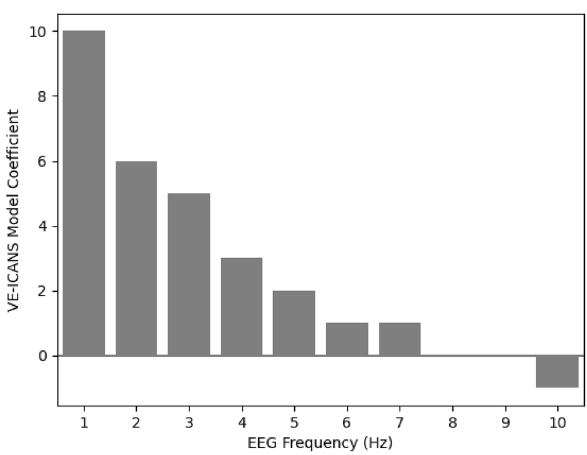
Figure 4. VE ICANS coefficients for each frequency (Hz) of slowing. A bar plot of the assigned coefficient values (y-axis) in the VE-ICANS model of various degrees of slowing (x-axis) showing how incremental increases in slowing are given more weight in prediction of ICANS severity. “Slowing” is defined as an EEG frequency less than 8 Hz.